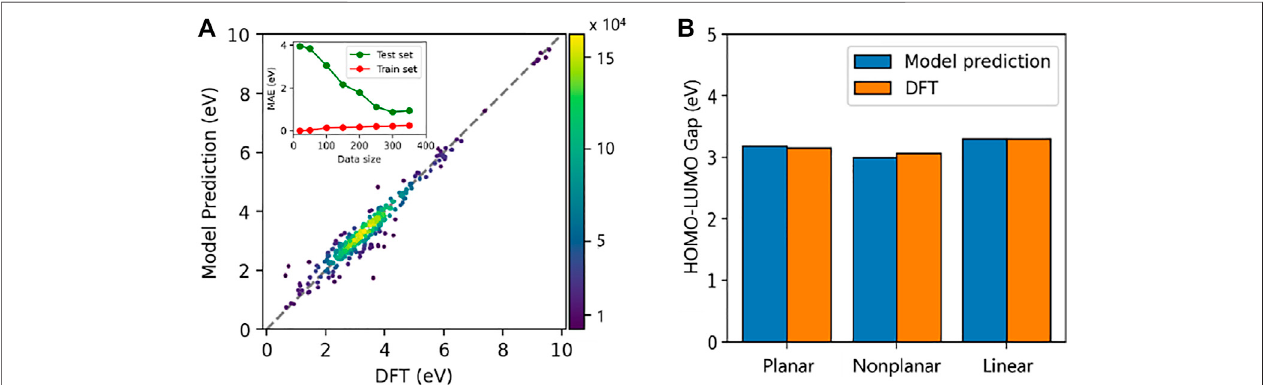
FIGURE11 |(A) HOMO-LUMO gaps of323 PAHs predicted bythe machine learningmodel and DFT calculations. Theinsetindicates theconvergence oflearning curve for the 10-fold cross-validation split of the data. (B) The average gap values of planar, nonplanar and linear PAHs calculated from DFT method and the machine learning model. The detail of PAH is included in Supplementary Table S3 – S5